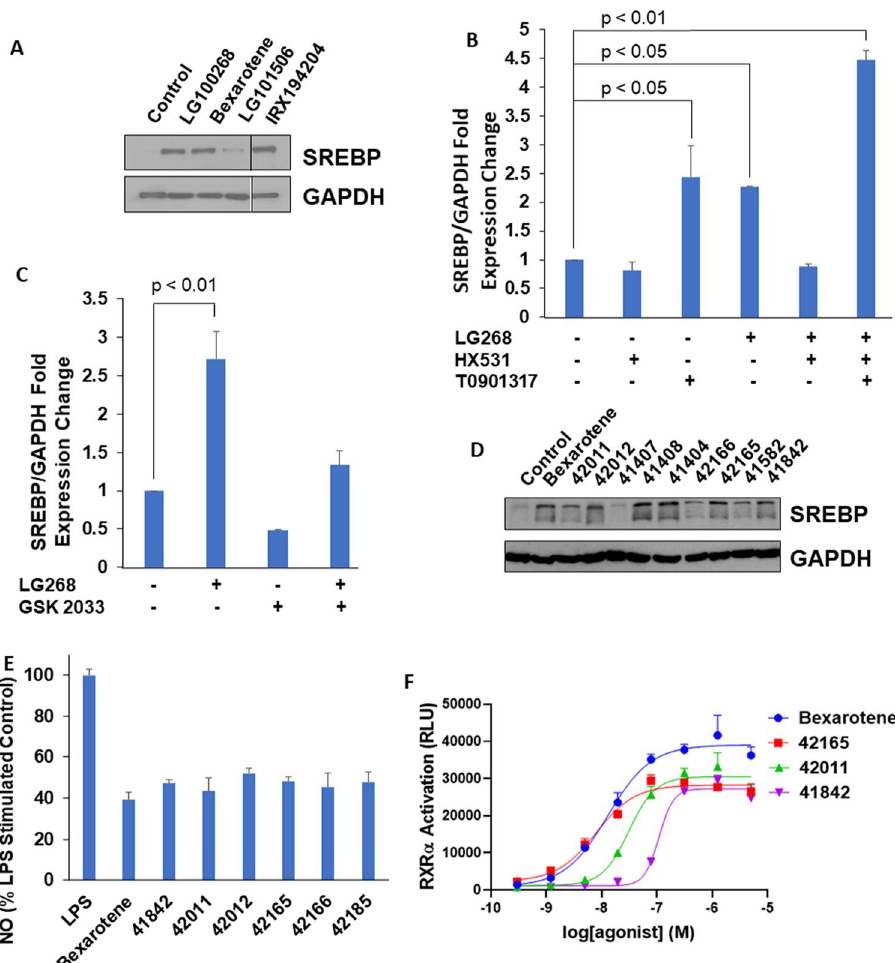
Figure 1. In vitro screening assays. ( A ): Established rexinoids alter SREBP protein expression. HepG2 cells were treated with 300 nM rexinoids for 24 hr and SREBP mRNA expression was quantified using RT-PCR. ( B ) Differences in SREBP protein expression induced by novel rexinoids. HepG2 cells were treated with 300 nM rexinoids for 24 hr and SREBP/GAPDH protein expression was measured by western blot. ( C ) SREBP mRNA expression. HepG2 cells were treated with 300 nM LG100268 (an RXR agonist) and/or 500 nM GSK 2033 (an LXR antagonist). SREBP mRNA expression was quantified using RT-PCR. ( D ) SREBP mRNA expression. HepG2cells were treated with 300 nM LG100268 (an RXR agonist), 100 nM HX 531 (an RXR antagonist), and/or 500 nM T0901317 (an LXR agonist). ( E ) iNOS inhibition of select novel compounds. RAW264.7 macrophage-like cells were treated with 300 nM rexinoids and stimulated with LPS for 24 h. NO in the media of treated cells was measured by the Griess assay. ( F ) RXR activation of select novel compounds. Reporter cells were treated with 0–5000 nM rexinoids and RXRα activation was measured using a commercially available